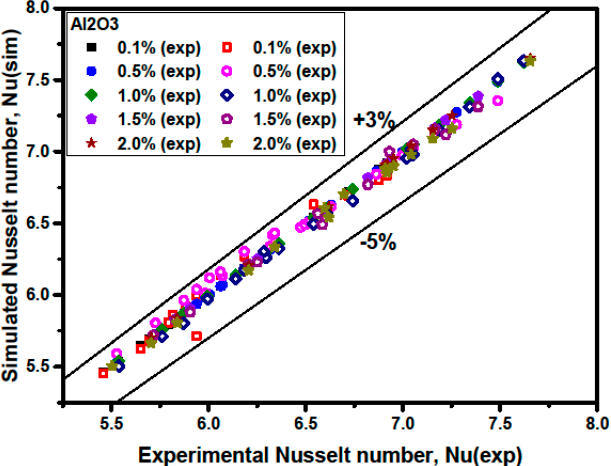
Figure 10. Comparison of measured and predicted Nusselt number for Al 2 O 3 /water nanofluids.